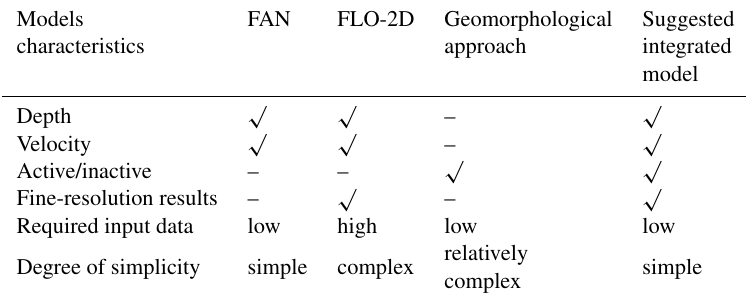
Table 5. Pros and cons of three models and the suggested integrated